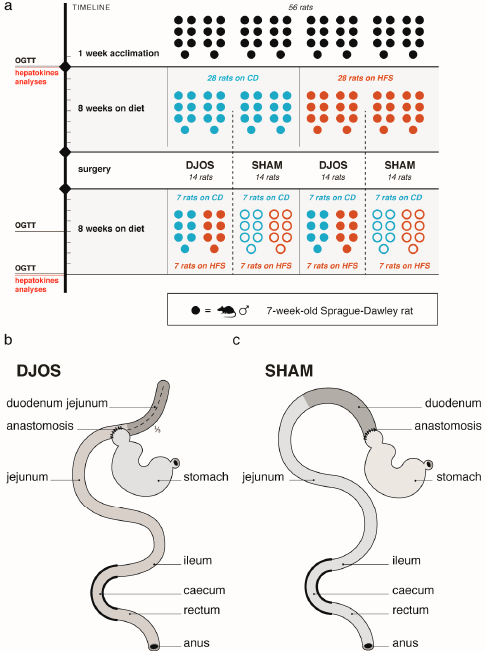
Figure 1. Study design: ( a ) experimental setup, ( b ) scheme of duodenojejunal omega switch (DJOS) surgery, ( c ) scheme of control (SHAM) surgery. Legend: CD—control diet, HFS—high fat, high sugar diet, DJOS—duodenojejunal omega switch, OGTT—oral glucose tolerance test, SHAM—control